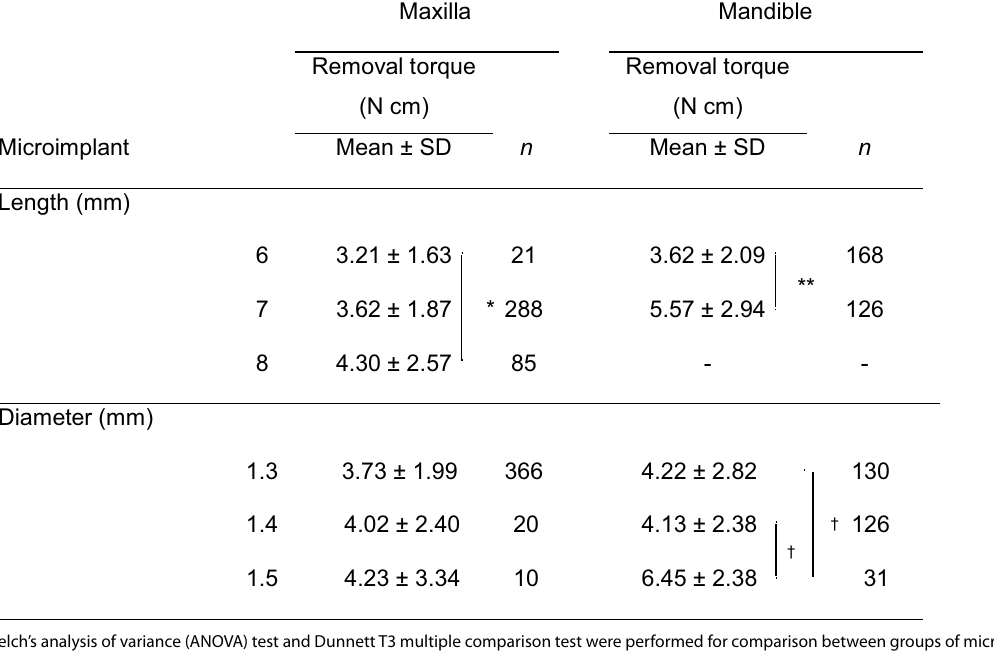
comparison between groups of microimplant diameter in the maxilla. One-way ANOVA with the post hoc Tukey’s test was performed for comparison between groups of microimplant diameter in the mandible